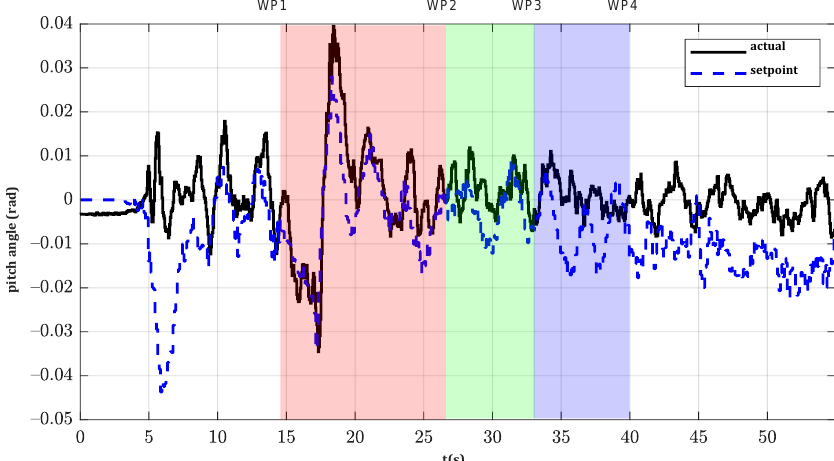
Figure 12. The roll angle of the UAV in clip installation.